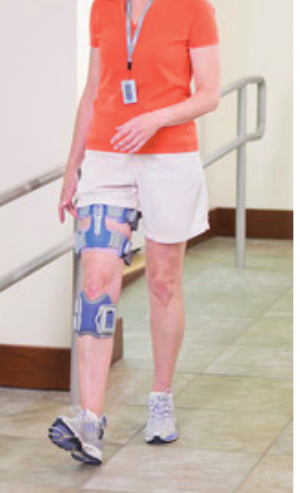
Figure 1: The NESS